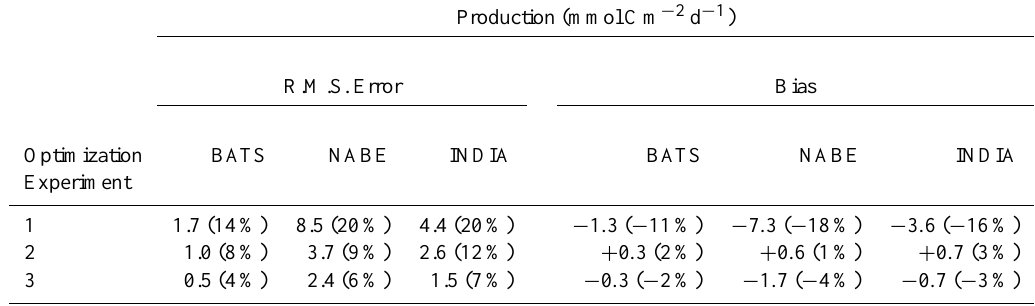
Table 6. Error in annual mean primary production.